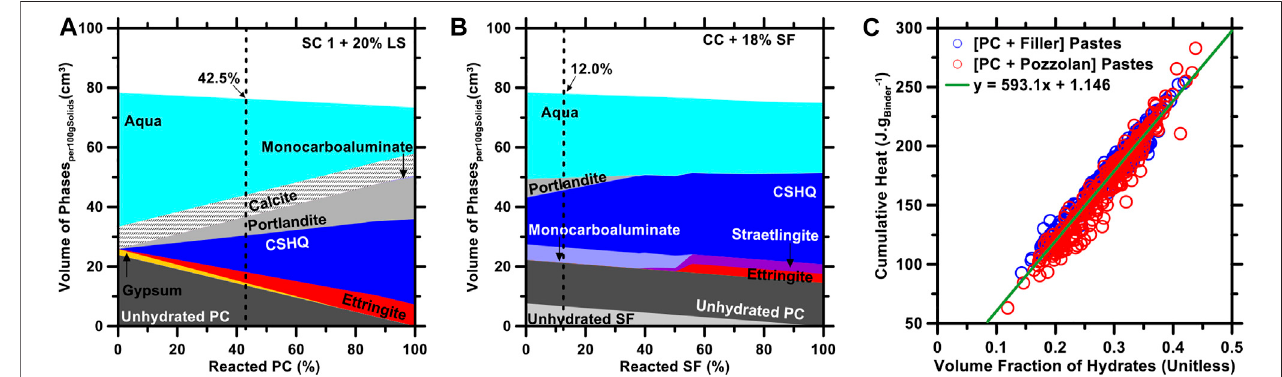
FIGURE6| (A) Equilibrium phase assemblage, estimated using GEMS,ofarepresentative (syntheticcement1+limestone(LS) pasteat 24 h. Thevertical dashed lineindicatesthephaseassemblageat24 hbasedonthedegreeofhydrationofPCasestimatedfromthecumulativeheatrelease. (B) Equilibriumphaseassemblageof arepresentative[commercialcement+silicafume(SF)]pasteattheageof24 h.Here,thedegreeofhydrationofPCat24 hisestimatedfromisothermalcalorimetry.The verticaldashedlinerepresentsthedegreeofreactionofsilicafume. (C) Alinearcorrelationbetweenvolumefractionofhydratesandcumulativeheatreleaseat24 h of ∼ 600[PC+SCM]pastesusedinthisstudy(PC+pozzolan)pastesaresilicafume-andmetakaolin-containingpastes;and(PC+ fi ller)pastesareeitherplainpastes,or pastes that contain limestone or